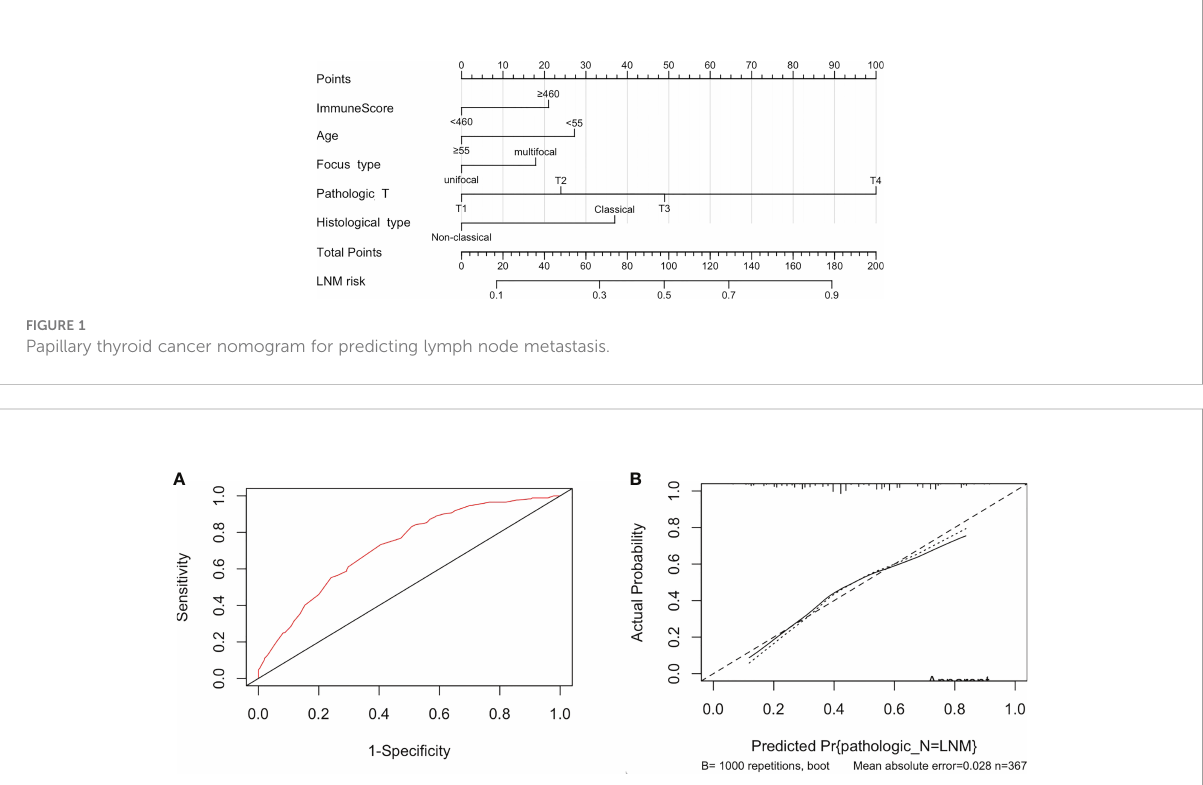
FIGURE 2 (A) The ROC curve of the immune-score-based nomogram. (B) The calibration curve of lymph node metastasis for papillary thyroid